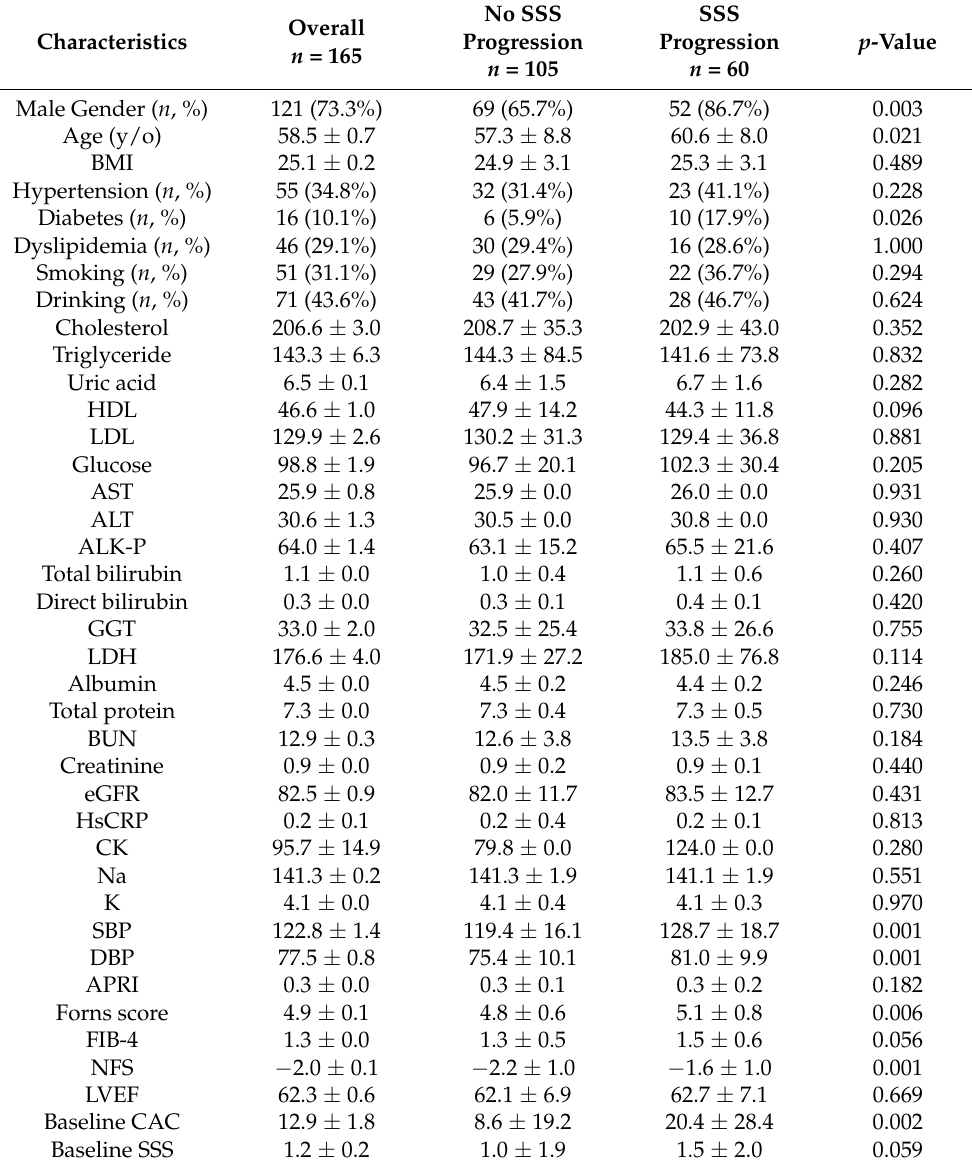
Table 2. Baseline characteristics of low-risk patients with and without SSS progression ( n = 165).